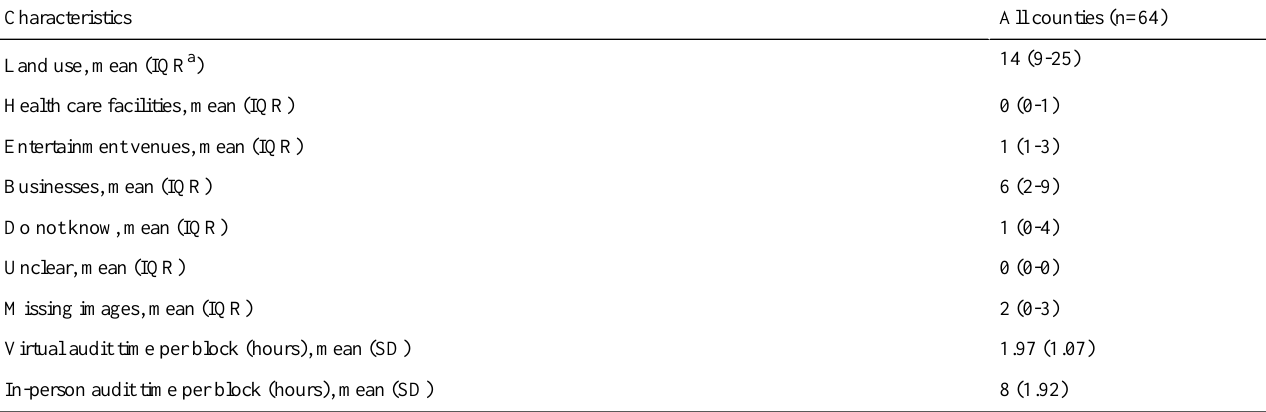
Table 1. Descriptive neighborhood characteristics collected using virtual audits for 5 counties in Kentucky